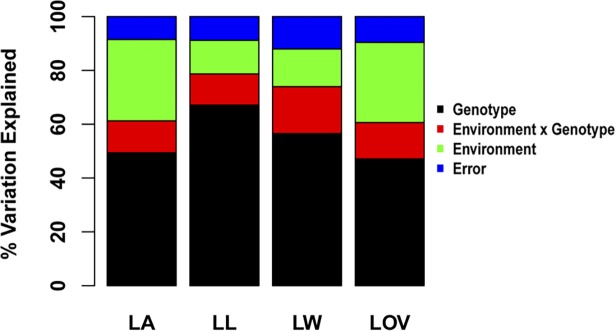
Partitioning variations in LA, LL, LW, and LOV across three populations.